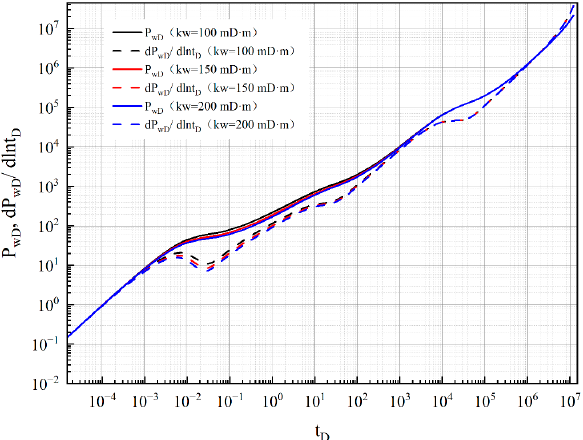
Figure 9. The effect of the hydraulic fracture conductivity coefficient on the pressure response.